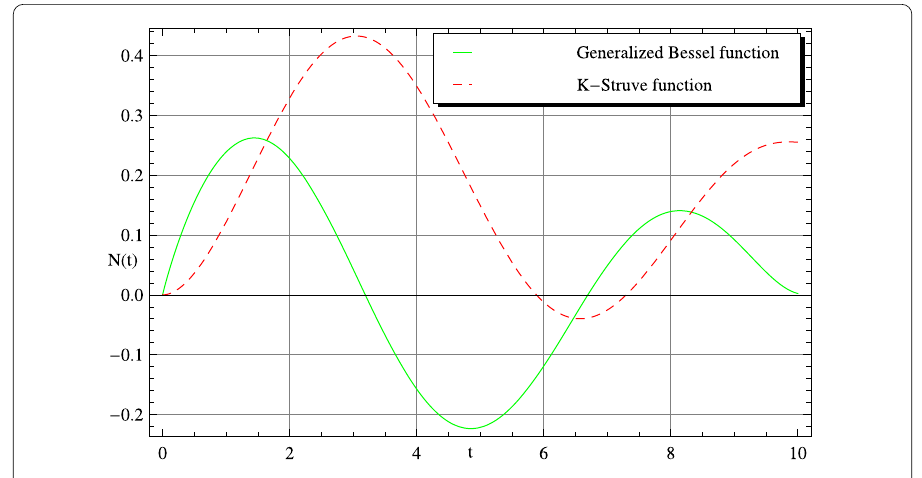
Figure 7 Comparison between solutions (22) and (18) of